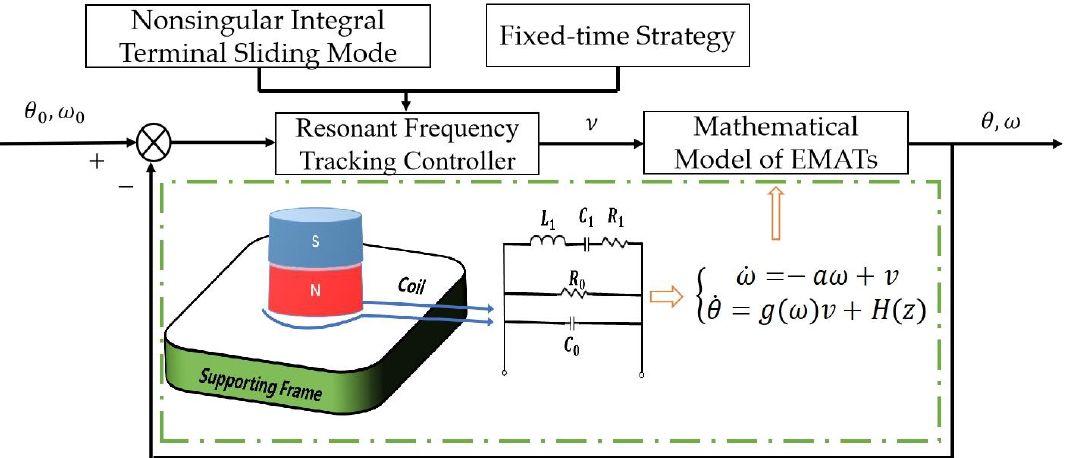
Figure 3. The control block diagram of FT-NITSM tracking control strategy for EMATs resonant frequency.